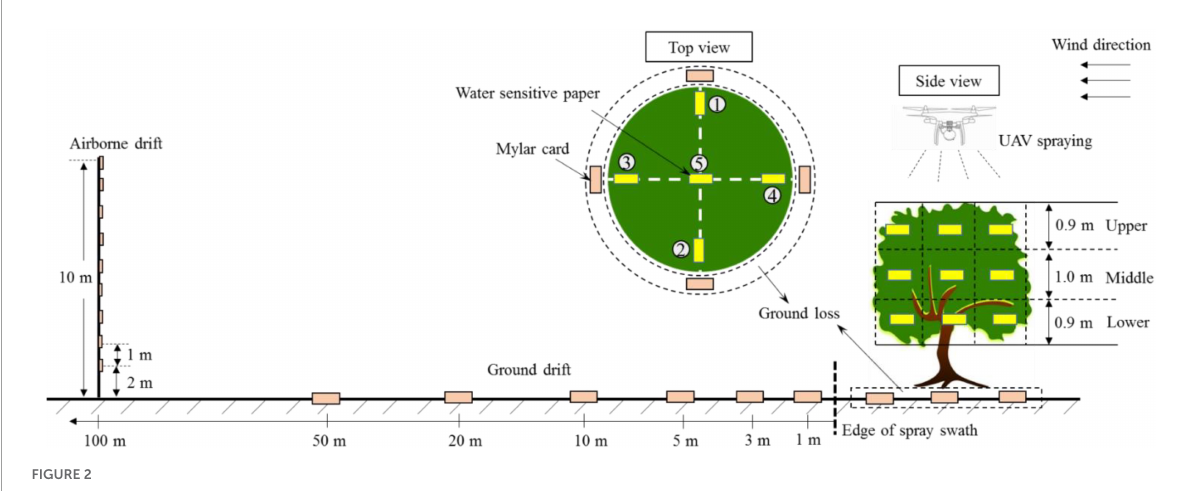
FIGURE2 Schematic diagram of sample layout in the treated